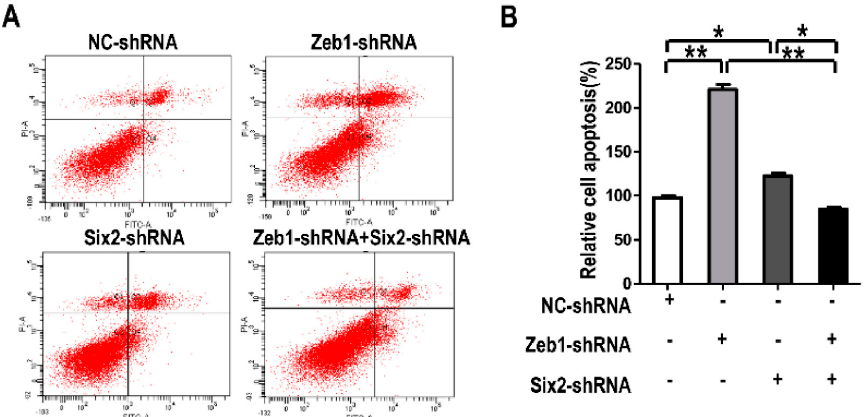
Figure 7. Zeb1 is required for mK3 cells to survival associated with Six2 . ( A ) mK3 cells were transfected same with Figure 6 and cell apoptosis was detected by reference to Figure 3. The rate of apoptosis in mK3 cells treated with single target shRNA is higher than the negative control shRNA, while mK3 cells treated double shRNAs had a lower rate than the single targeted mK3 cells; ( B ) Cell apoptosis rate was quantified and presented as mean ± SD ( n = 3). * p < 0.05, ** p < 0.01, respective controls.